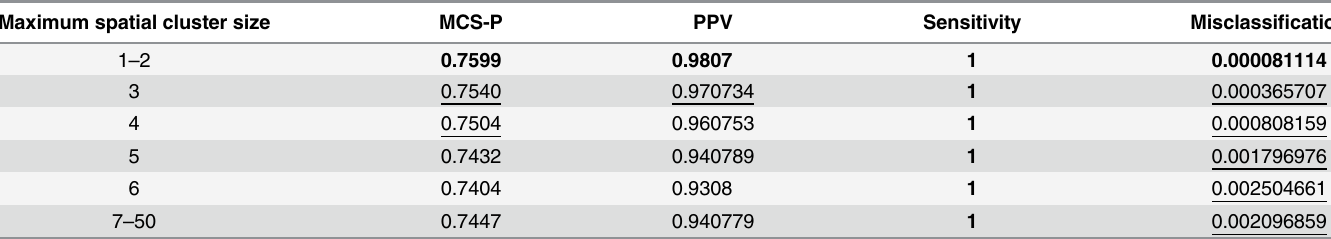
Table 6. Average performance measures for different maximum spatial cluster sizes in